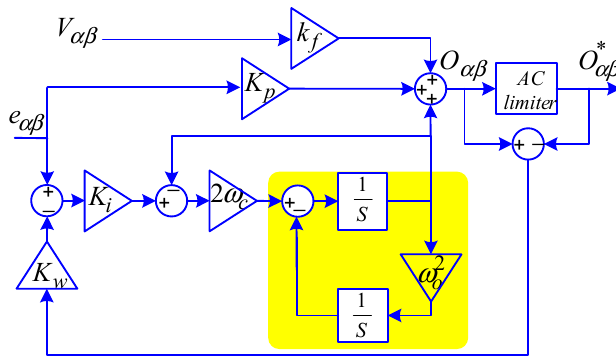
Figure 13. Block diagram of proposed PR controller with anti-wind-up capability.